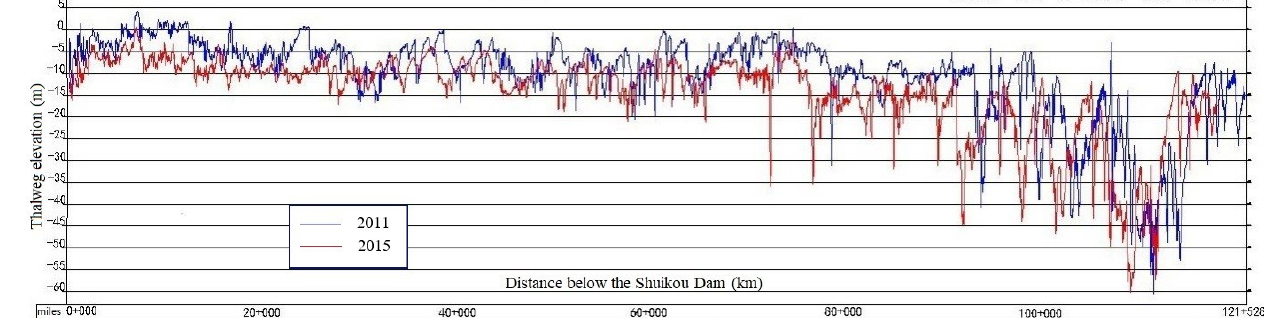
Figure 5. Comparison of thalwegs of the lower Minjiang River in 2011 and